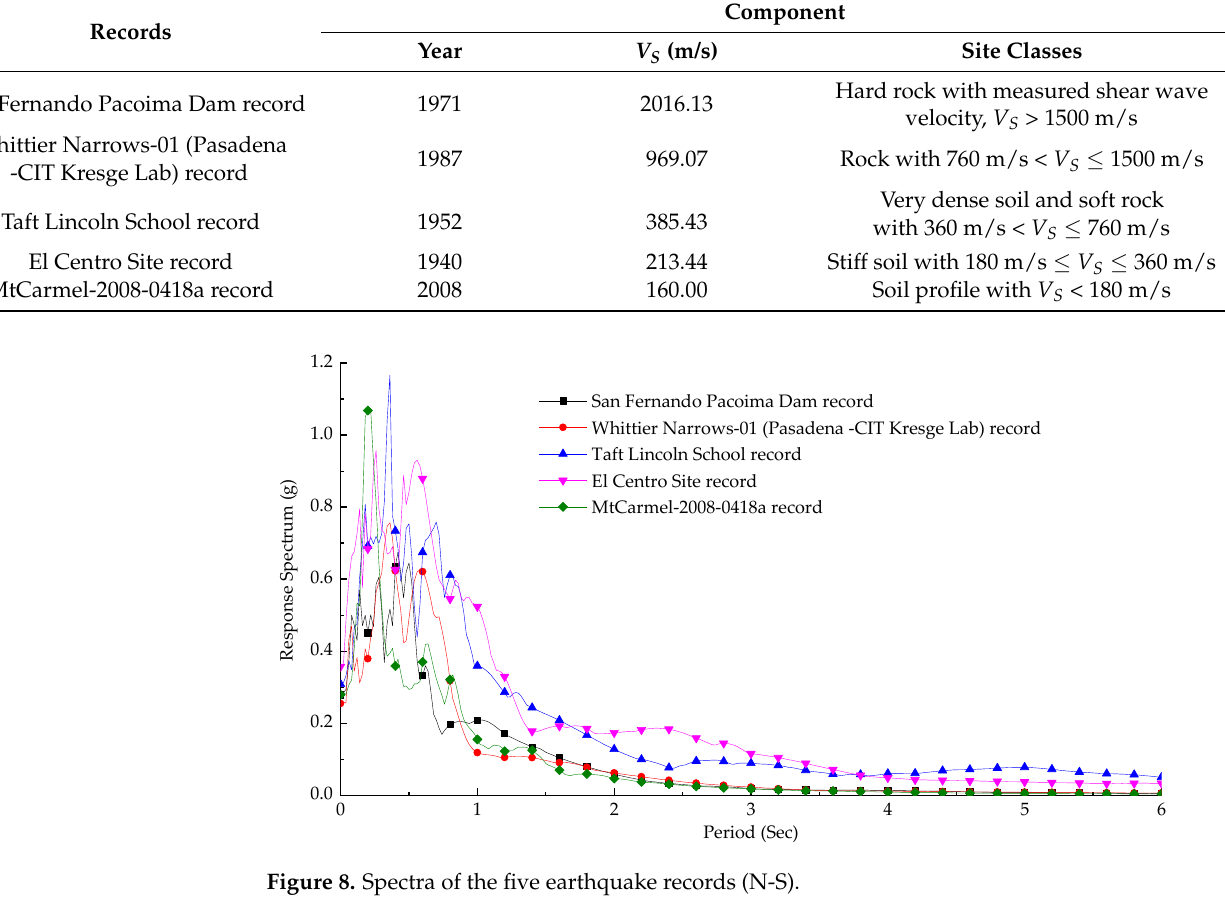
Table 3. The first four lateral vibration modes of the bridge with different layout schemes.